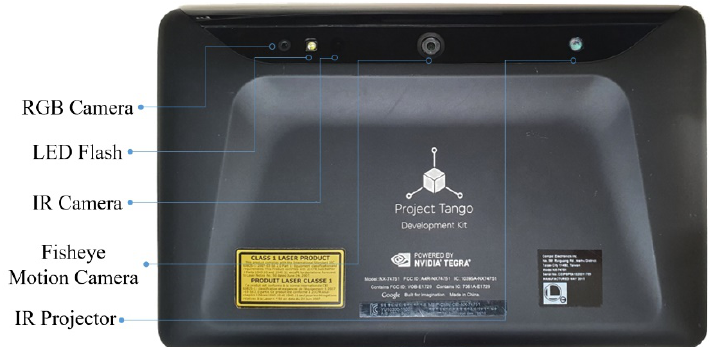
Figure 6. Google’s AR platform, Project Tango Development Kit.